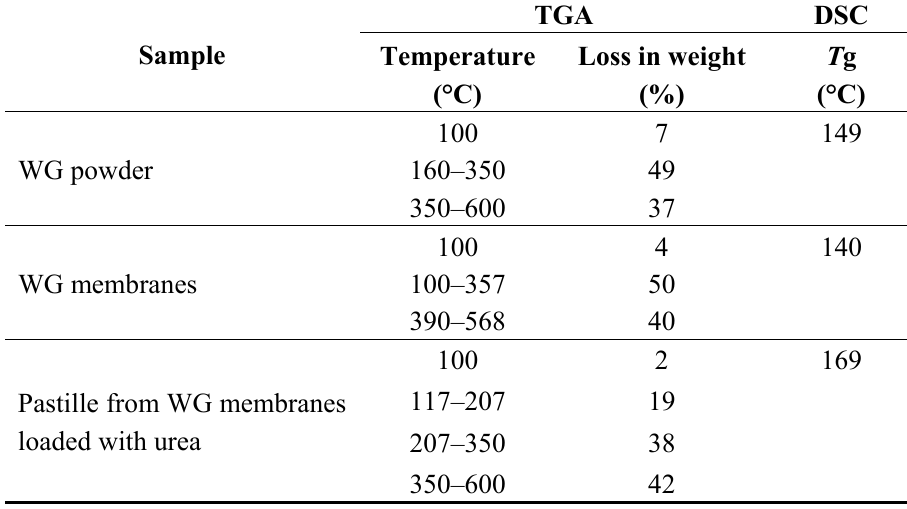
Table 2. Thermogravimetric analysis (TGA) and Glass transition temperature ( T g) obtained by differential scanning calorimetry